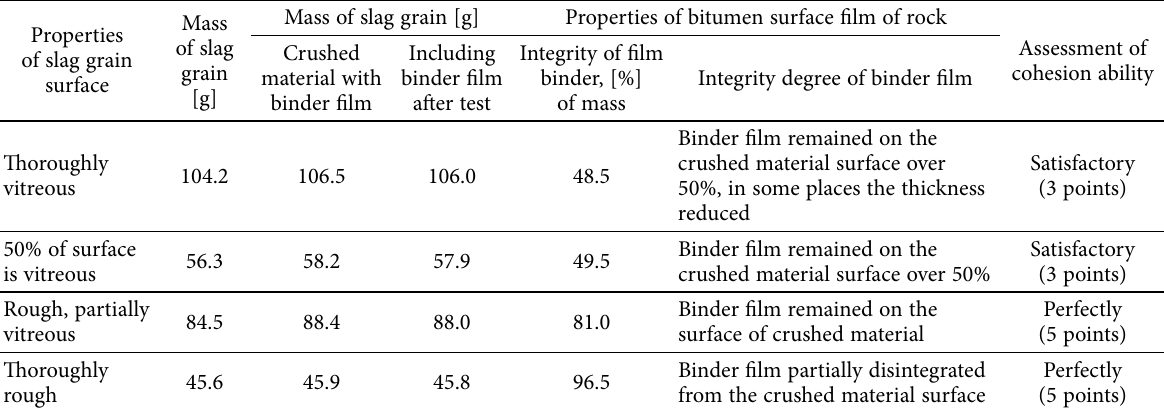
Table 5. Definition of cohesion ability of the surface of crushed material produced from slag with bitumen binder